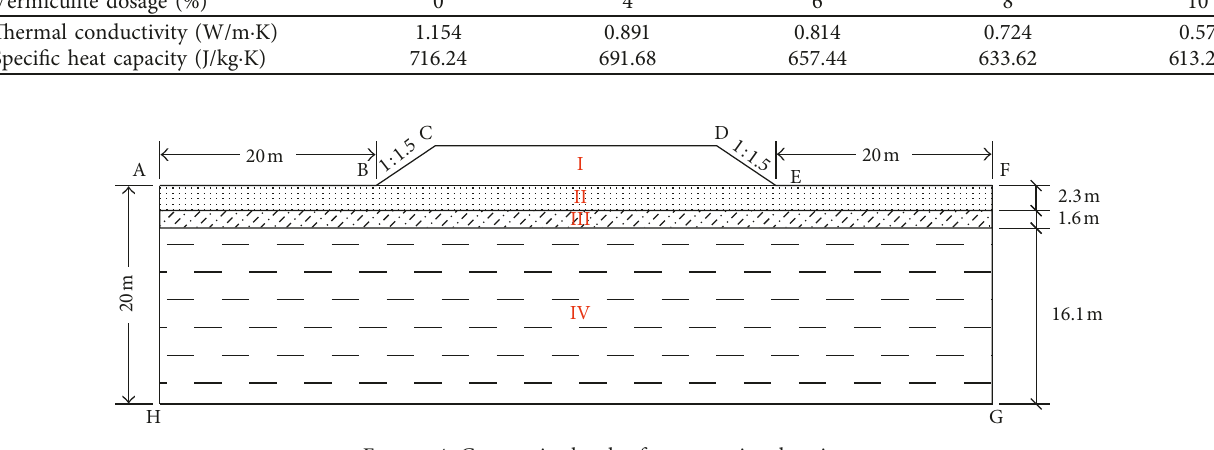
Figure 4: Geometric sketch of computational region.